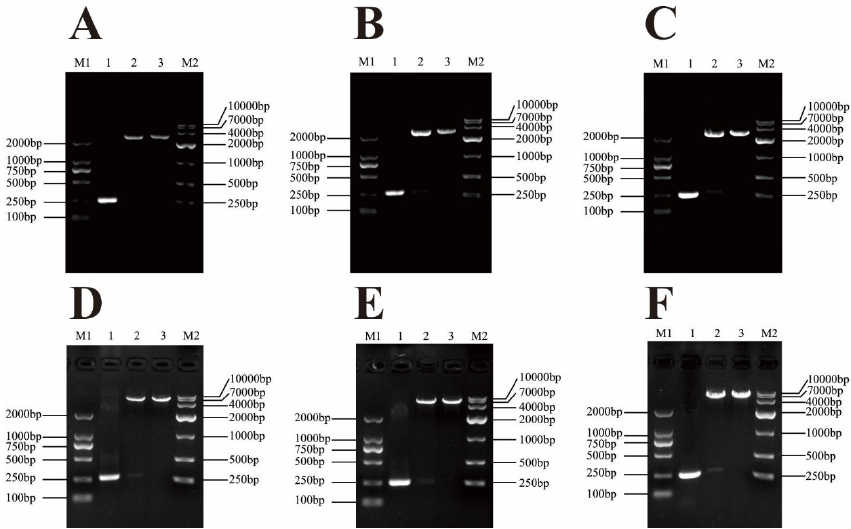
Figure 2. Identification of the recombinant plasmid pMD19 ‐ T ‐ mNKLs and pET ‐ 32a ‐ mNKLs by restriction digestion and PCR ‐ based amplification. ( A – C ) M1, DNA marker of 2000 bp; M2, DNA marker of 10,000 bp; lane 1, PCR amplification product of mNKL 1, mNKL 2 and mNKL 3, respectively (approximately 260 bp); lane 2, pMD19 ‐ T ‐ mNKL 1/2/3 were digested by Bam H I and Hind III; lane 3, pMD19 ‐ T ‐ mNKL1/2/3 were digested by Bam H I; ( D – F ) M1, DNA marker of 2000 bp; M2, DNA marker of 10,000 bp; lane 1, PCR amplification product of mNKL 1, mNKL 2 and mNKL 3, respectively (approximately 260 bp); lane 2, pET ‐ 32a ‐ mNKL 1/2/3 were digested by Bam H I and Hind III; lane 3, pET ‐ 32a ‐ mNKL 1/2/3 were digested by Bam H I.